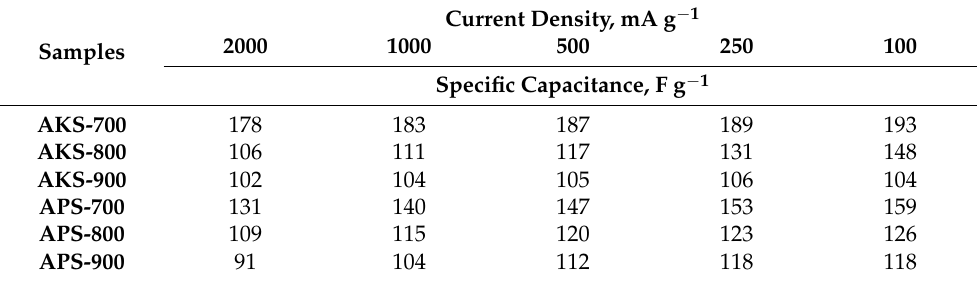
Table 4. The specific capacitance of AKS and APS calculated by the GCD data at different current